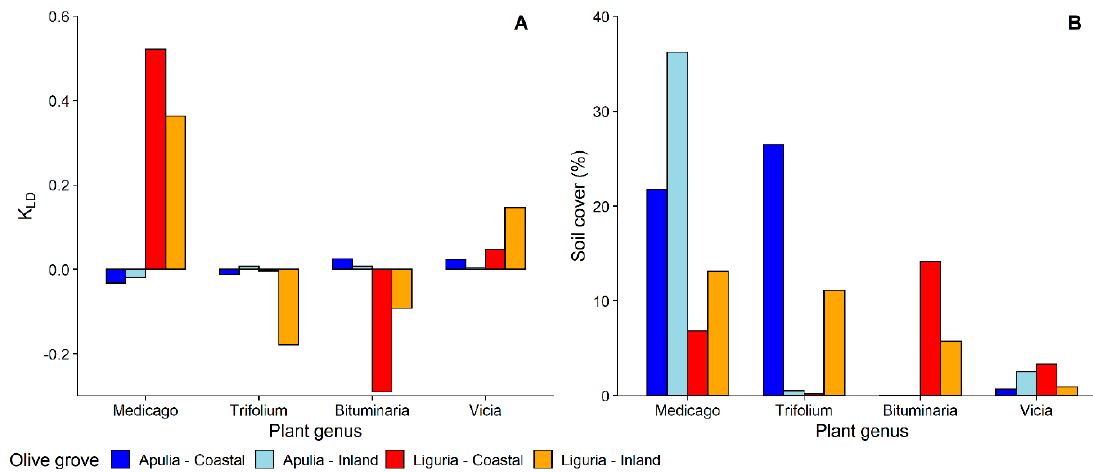
Figure 4. ( A ) Selection of most common plant genera of Fabaceae by nymphs of Philaenus spumarius — Kullback–Leibler divergence ( 𝐷 (cid:3012)(cid:3013) ) measure; ( B ) relative percentage of soil cover of most